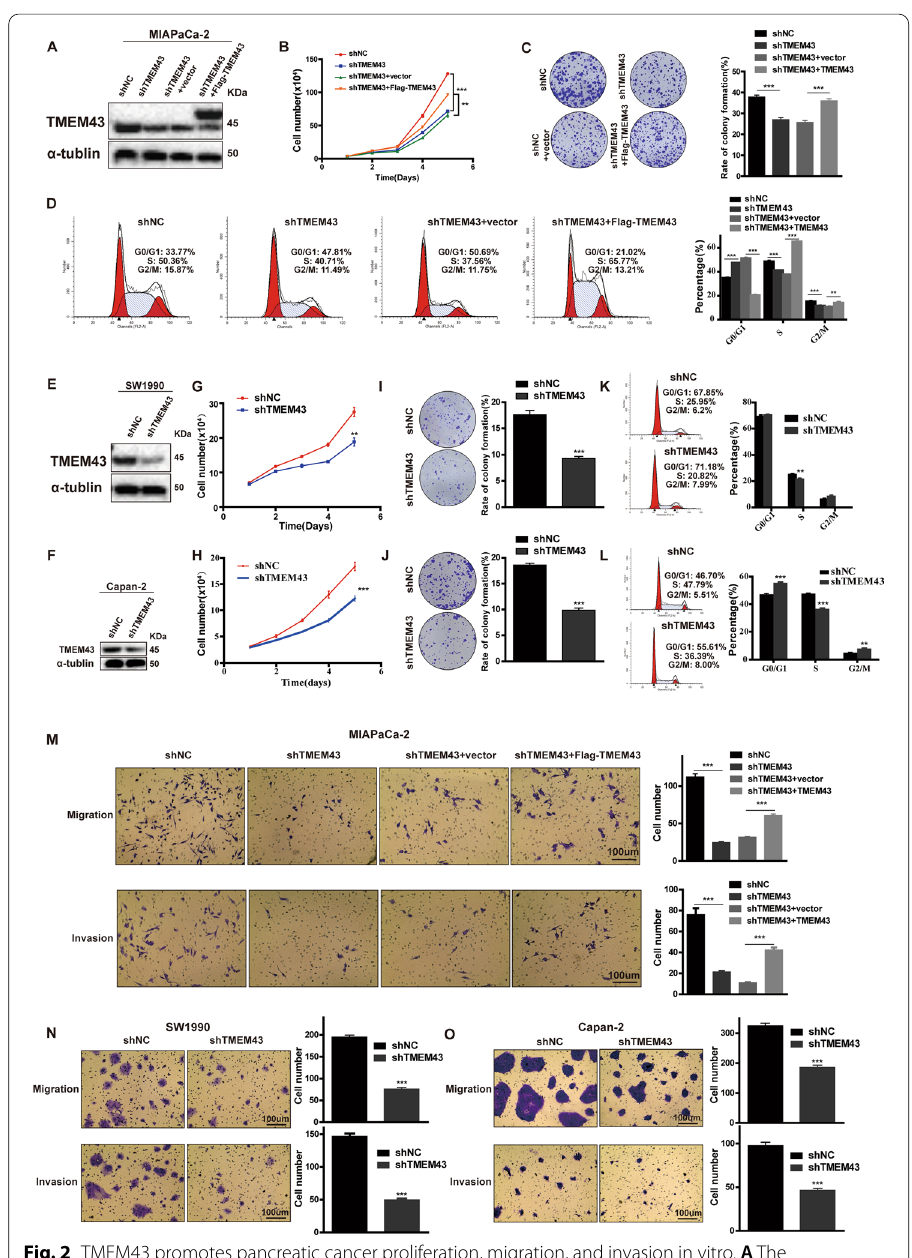
Fig. 2 TMEM43 promotes pancreatic cancer proliferation, migration, and invasion in vitro. A The protein expression levels of TMEM43 were detected using western blotting in TMEM43-silenced cells and TMEM43-overexpressing MIAPaCa-2 cells. B , C Cell counting and colony formation assays showed the effects of silencing and overexpressing TMEM43 on MIAPaCa-2 cell proliferation. D The effects of silencing and overexpressing TMEM43 on pancreatic cancer cell cycle using flow cytometry assays. E , F The protein expression levels of TMEM43 were measured in TMEM43-knockdown SW1990, Capan-2 cells, and the corresponding control cells. G – J Cell counting and colony formation assays were performed in TMEM43-silenced SW1990, Capan-2 cells, and the corresponding control cells. K , L The cell cycle was analyzed in TMEM43-silenced SW1990, Capan-2 cells, and control cells with flow cytometry assays. M – O The migration and invasion abilities were detected in TMEM43-silenced MIAPaCa-2, SW1990, Capan-2 cells, TMEM43-overexpressing MIAPaCa-2 cells, and the corresponding control cells using transwell assays. Scale bar 100 μm. Results are shown as the mean SD of three independent replicates. Scale bar 100 μm. = ± = * p < 0.05, ** p < 0.01, *** p <